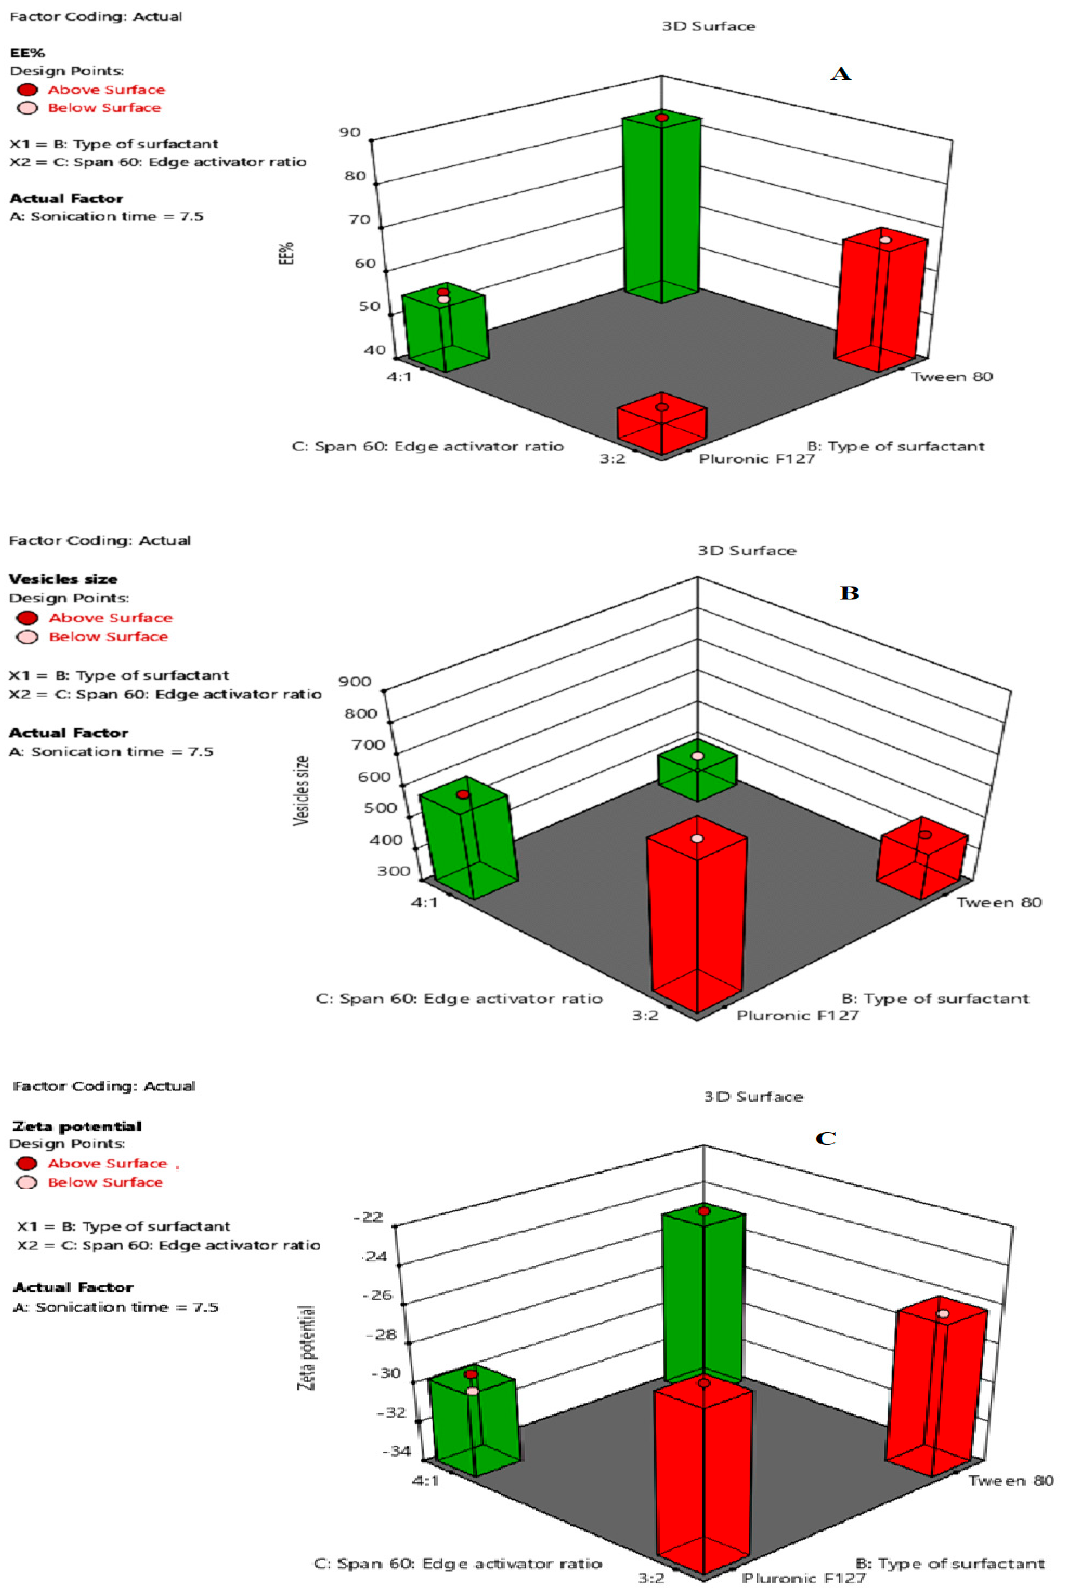
Figure 1. Response surface plots for the effects of type of surfactant (X1), Span-60:EA ratio (X2), and sonication time (X3) on: ( A ) EE%; ( B ) vesicles’ size; and ( C ) zeta potential, respectively.